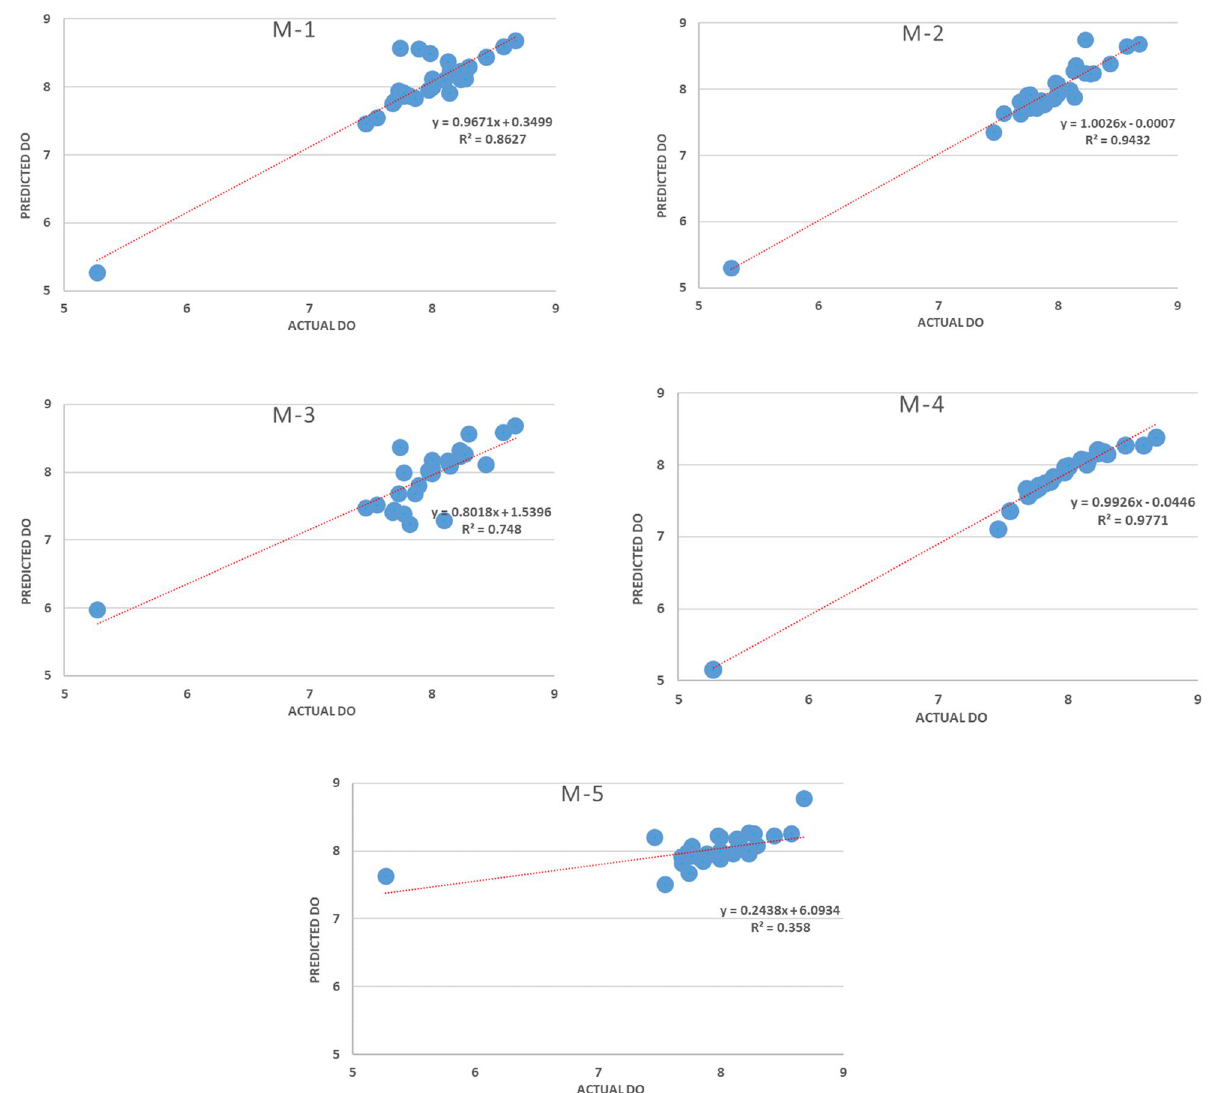
Figure 8. Predicted vs. actual scatter